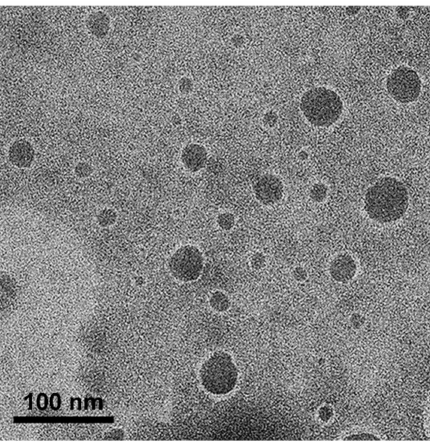
Figure 4. TEM images of selected APC-SNEDDS on phase behavior of oil in water systems (50,000 ×